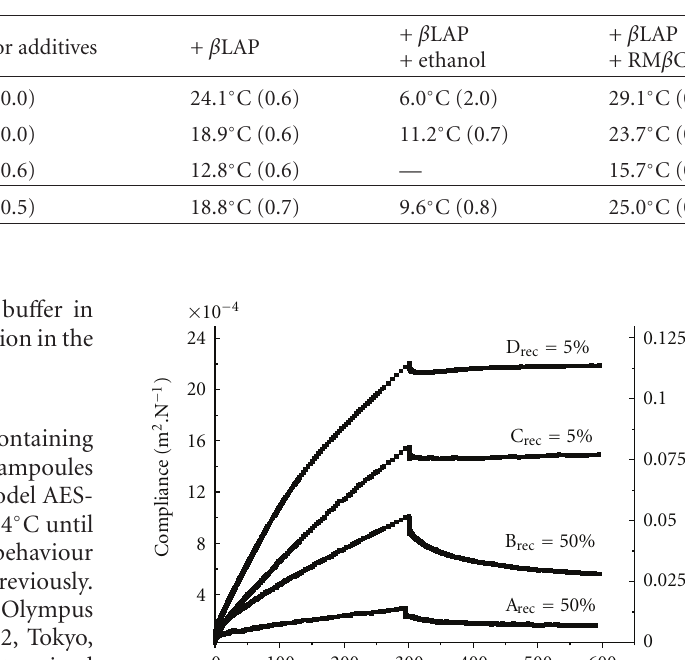
Table 1: Gel temperature of Pluronic F127 and P123 systems solely or containing 5% (w/v) RM β CD and 20% (v/v) ethanol: mean values and, in parenthesis, the standard deviations.